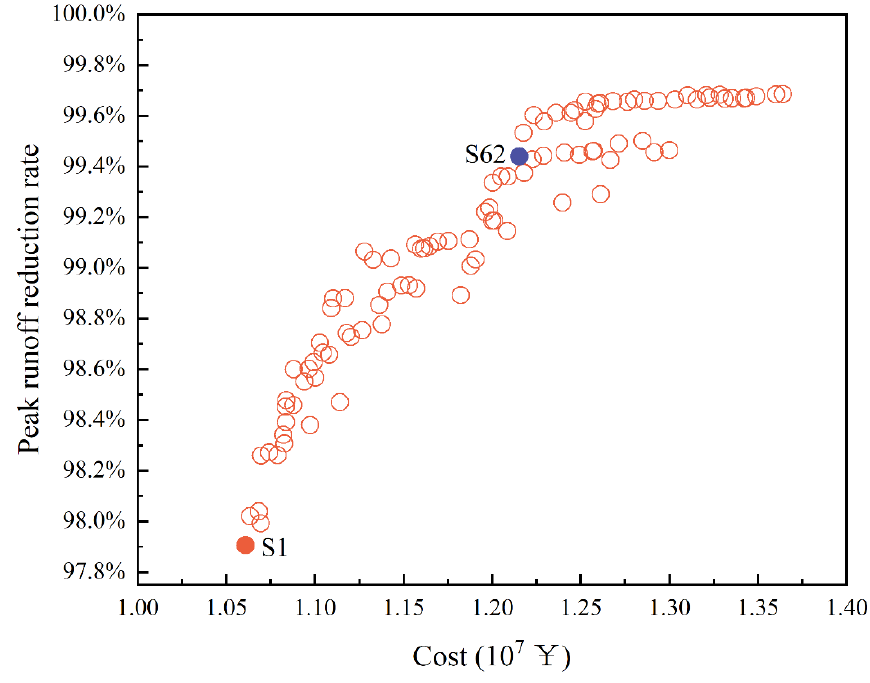
Figure 8. A plot of the peak runoff abatement rate–cost relationship.